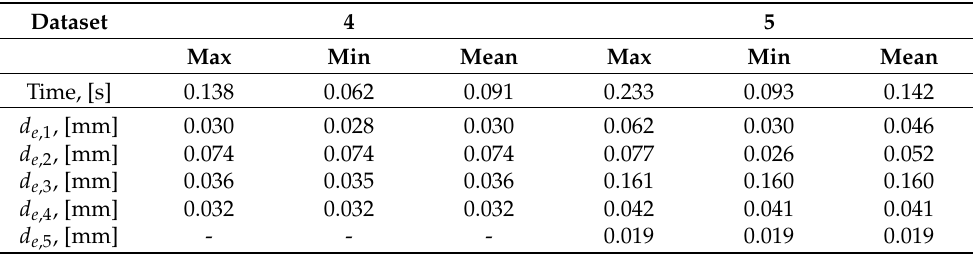
Table 3. Segment fit errors and execution times for 10 sequential runs using datasets 4 and 5. The fit error definition is given in the beginning of Section